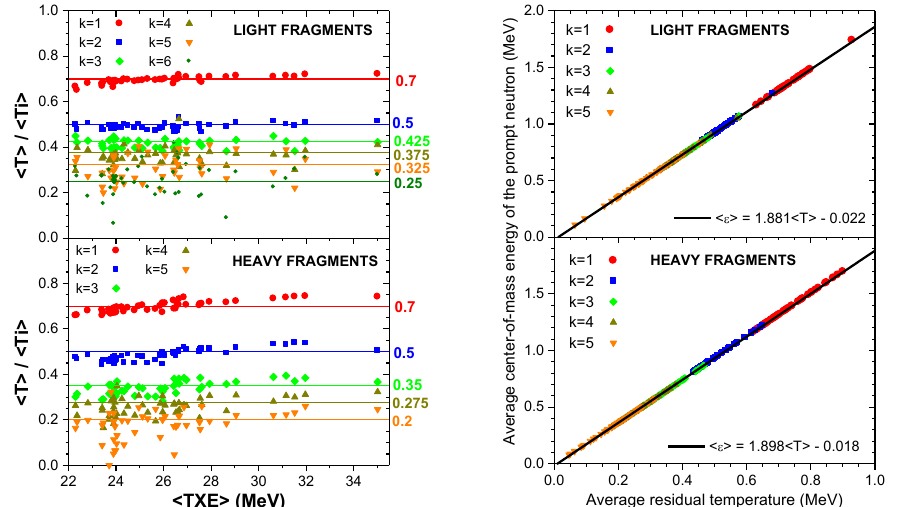
Fig.4. Left part: the ratios <T k >/<T i > as a function of TXE resulting from the sequential emission calculations (different symbols corresponding to each sequence) and the constant values approximating these ratios (lines plotted with the same colour as the respective symbol). Right part the average centre- of-mass energy of each emitted neutron < ε > k as a function of <T k > (using the same symbols and colours as in the left part) and its linear fit (black